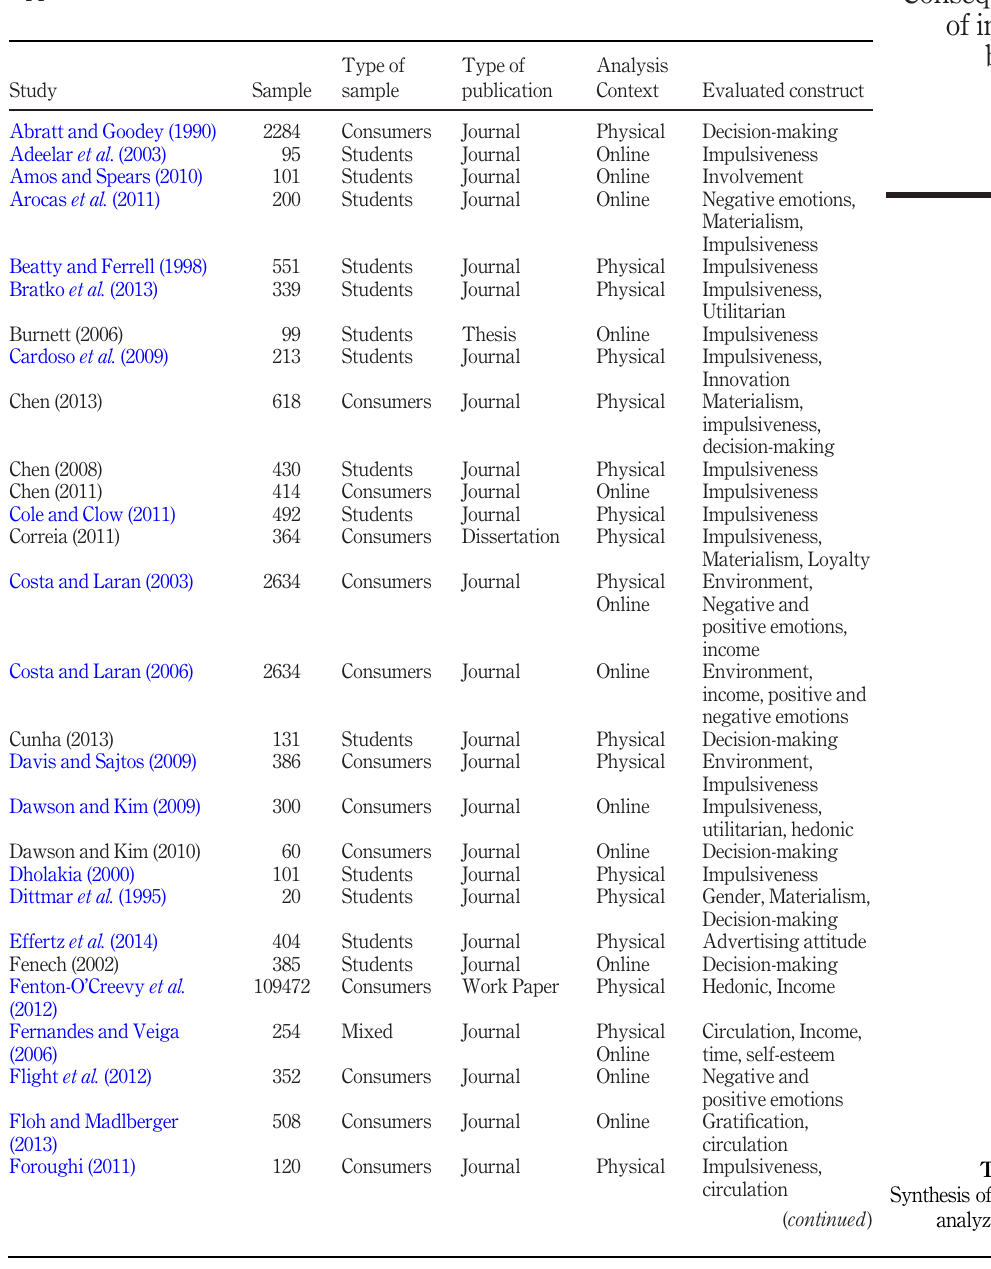
Table AI. Synthesis of the